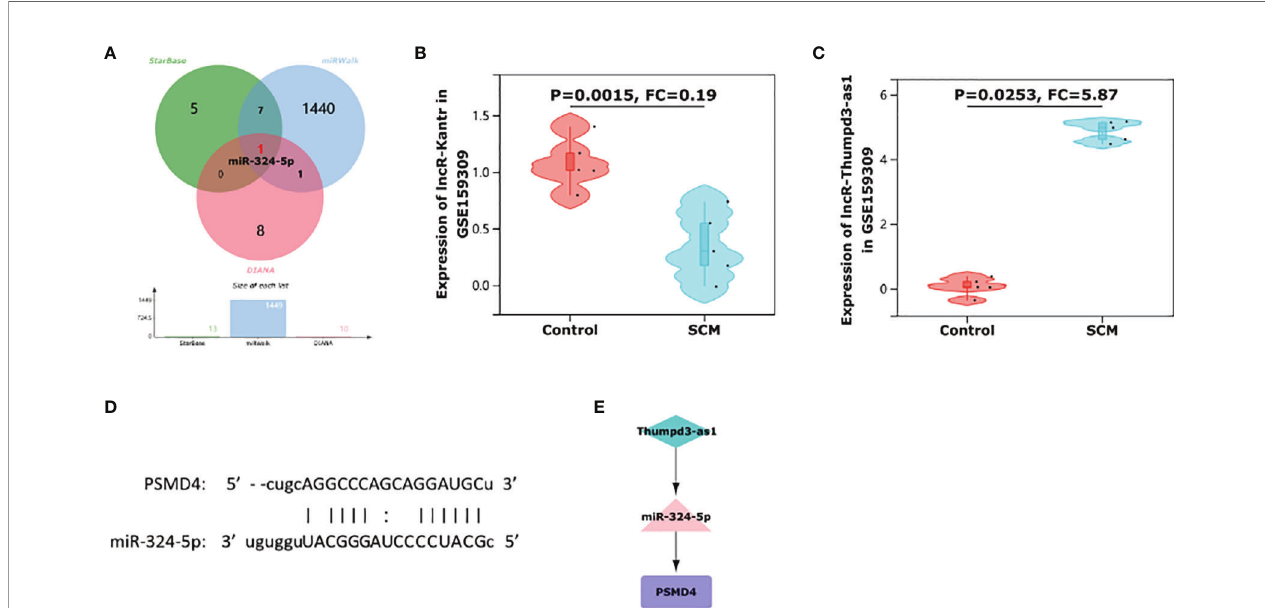
FIGURE 7 | Construction of immune-related ceRNA network Thumpd3-as1/miR-324-5p/PSMD4. (A) A Venn diagram of shared target miRNAs of PSMD4 of the three databases. (B) The violin plot represents the expression of Kantr in rat cardiomyocytes in the dataset GSE159309. (C) The violin plot represents the expression of Thumpd3- as1 in rat cardiomyocytes in the dataset GSE159309. (D) Binding site map of miR-324-5p and PSMD4. (E) Thumpd3-as1/miR-324-5p/PSMD4 ceRNA